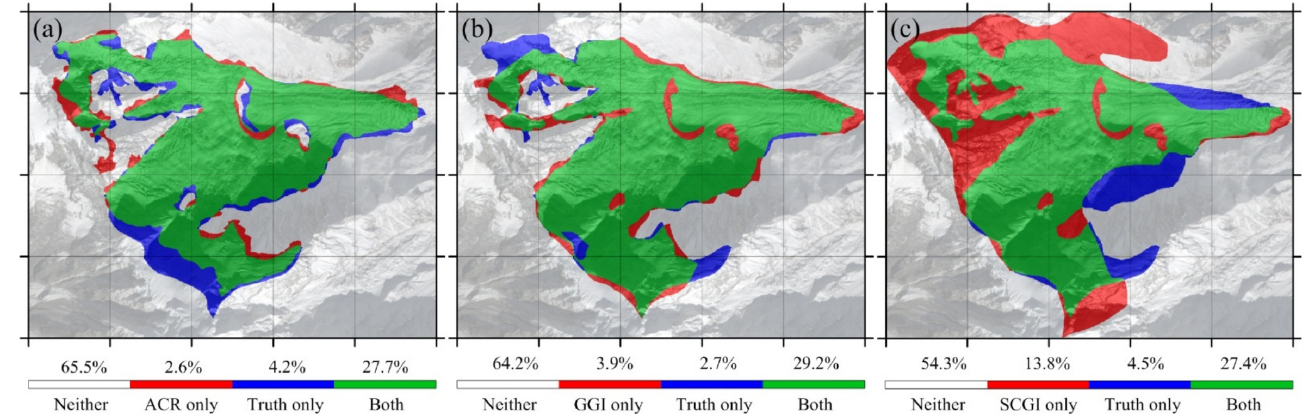
Figure 9. ( a – c ) is the spatial relationships between ground truth and glacier boundaries of our result, GGI, and SCGI, respectively. Table 4. Comparison of the area, difference, difference rate, misclassification rate, and difference rate between the true glacier boundary and those from the ACR map, GGI, and SCGI.